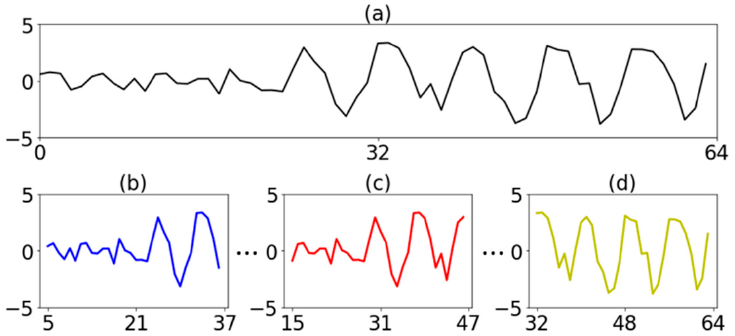
Figure 2. Variants of non-random pattern in the course of classification. ( a ) Original data. ( b – d ) Data in different classification stages before being classified as non-random.